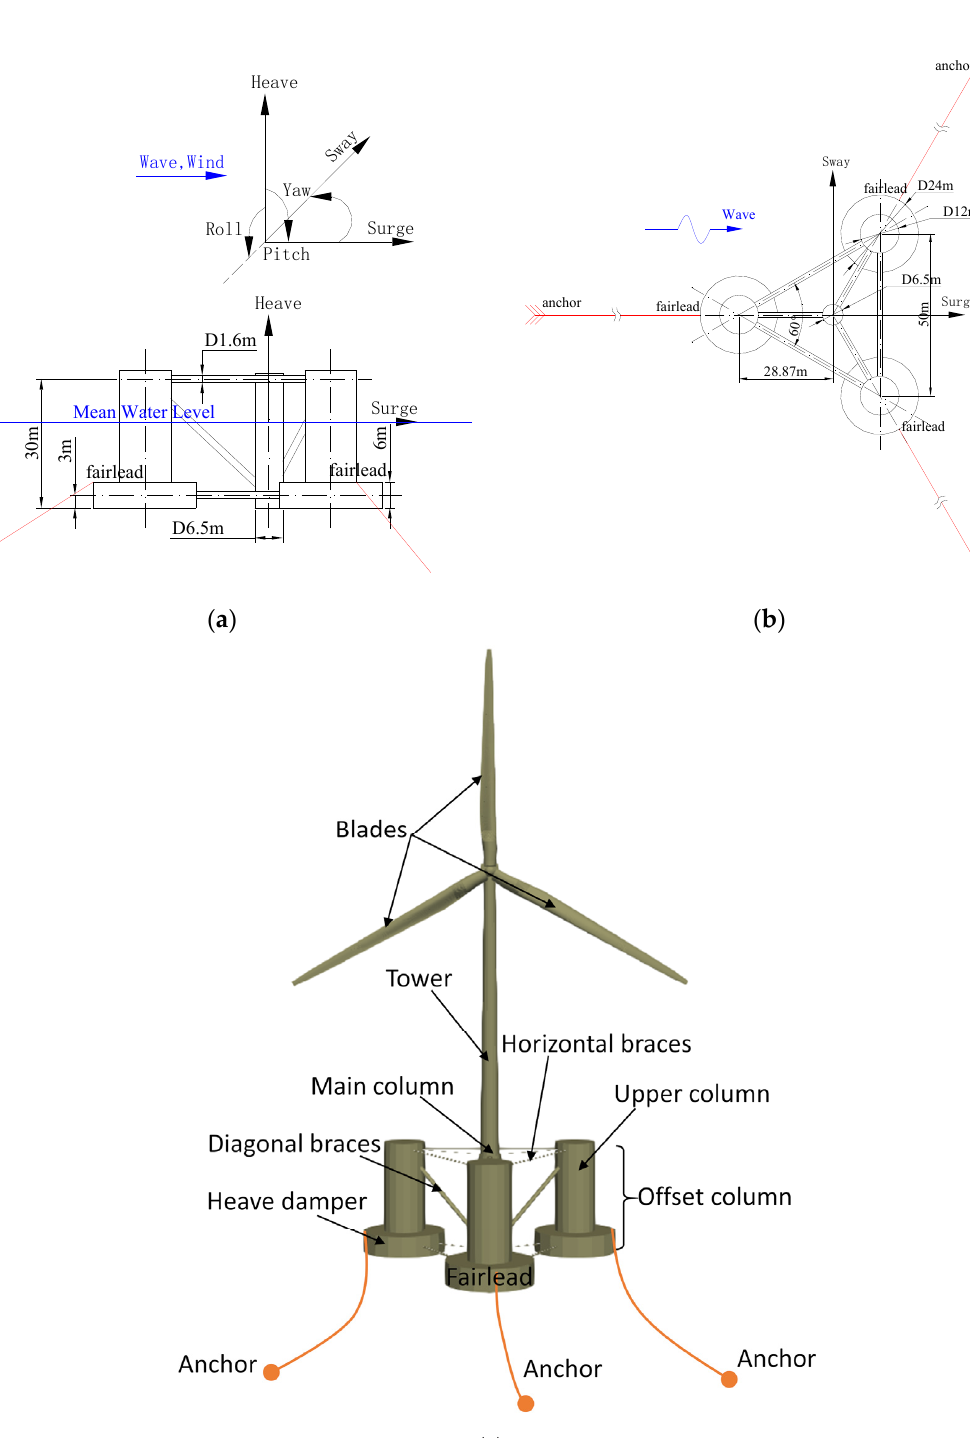
Figure 2. Sketch of the DeepCwind semi-submersible floating system (Model 0), ( a ) side view, ( b ) bird view, and ( c ) isometric view of the DeepCwind semi-submersible floating platform. The six DOF are defined as surge, sway, heave, roll, pitch, and yaw. For all simulations presented, the direction of wave propagation is aligned with the platform, which is in the surge